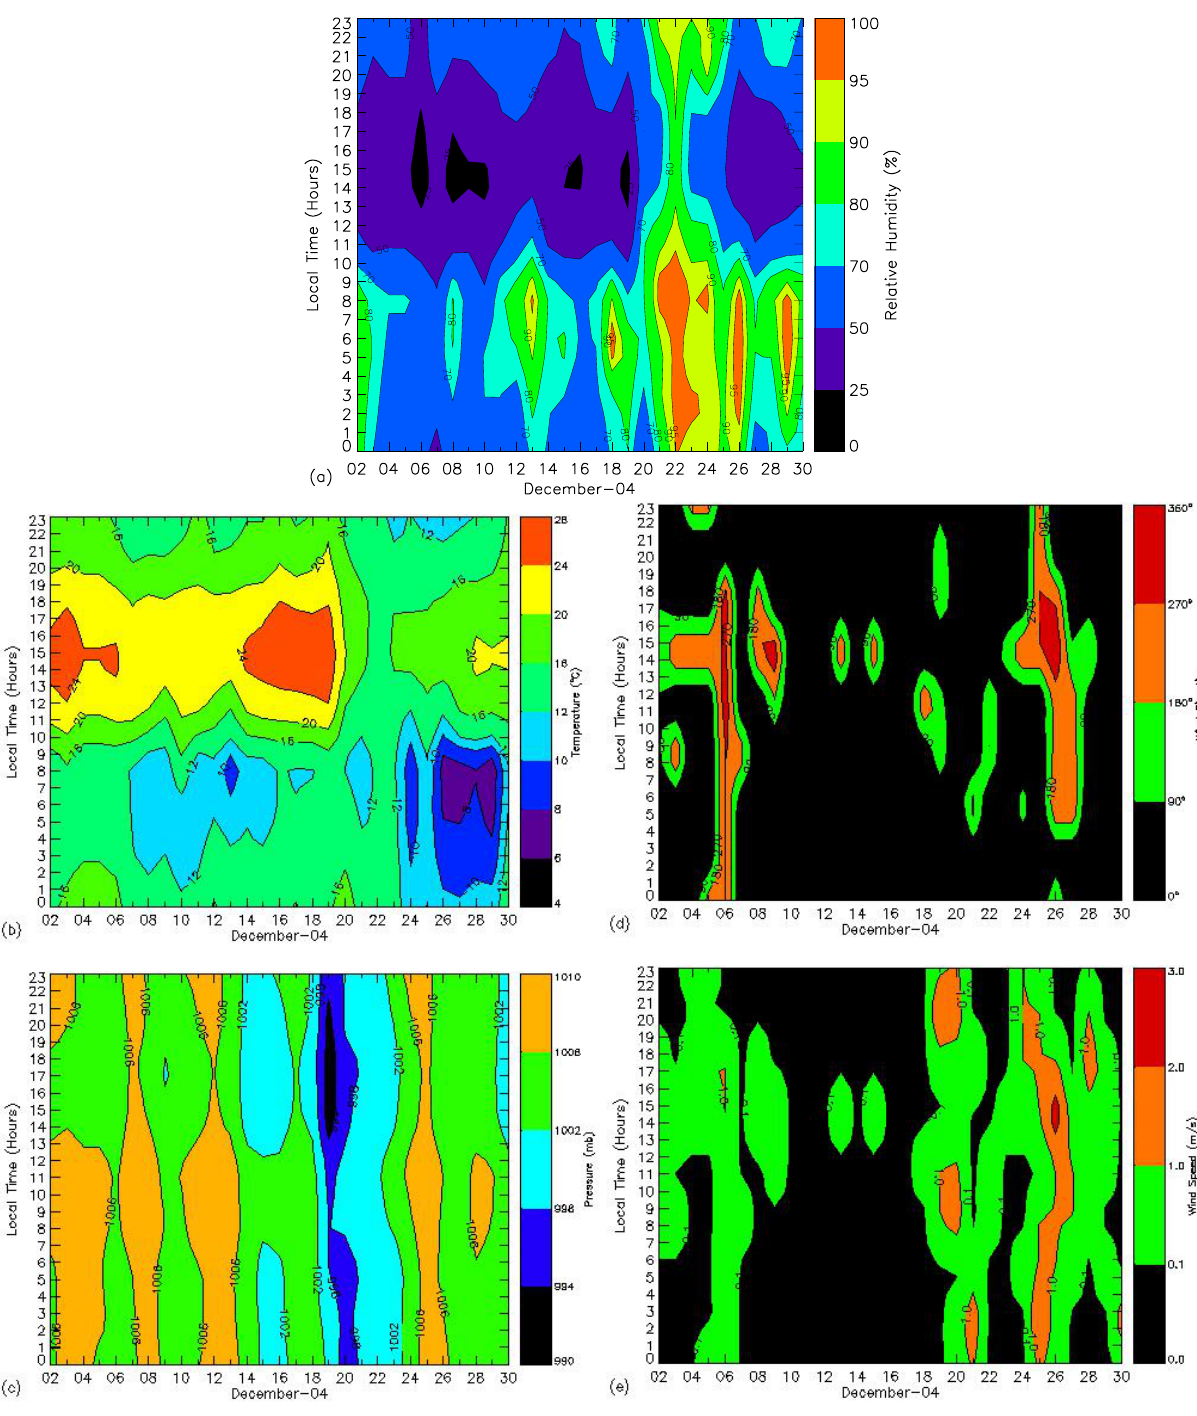
Fig. 2. Relative humidity, temperature, pressure, wind direction and speed observed at Hissar during the campaign period. Foggy periods are observed (Fig. 2a) on 12, 13, 14, 20 and 22, 26 and 29 December when the RH values are above